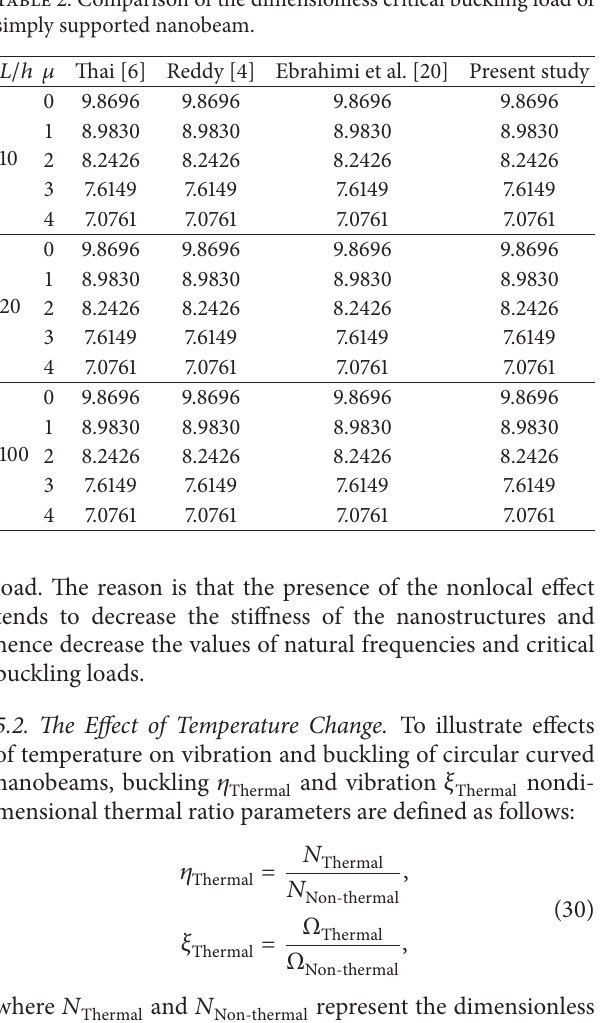
Figure 4: Buckling thermal ratio parameter of circular curved nanobeam with respect to temperature change (𝜇 = 1, 𝐾 𝑤 = = 10 −6 , 𝑅 = 10 nm ) . 10 10 , 𝐾 𝑝